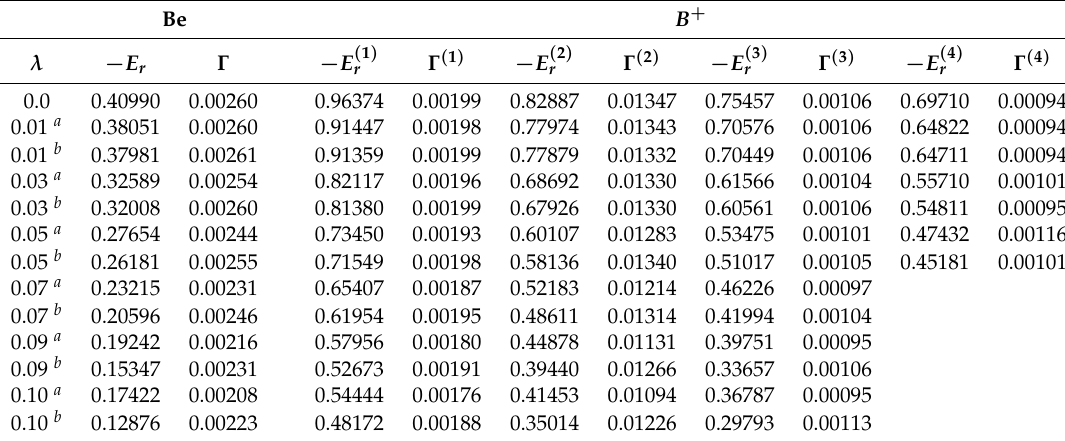
). Energies were 0